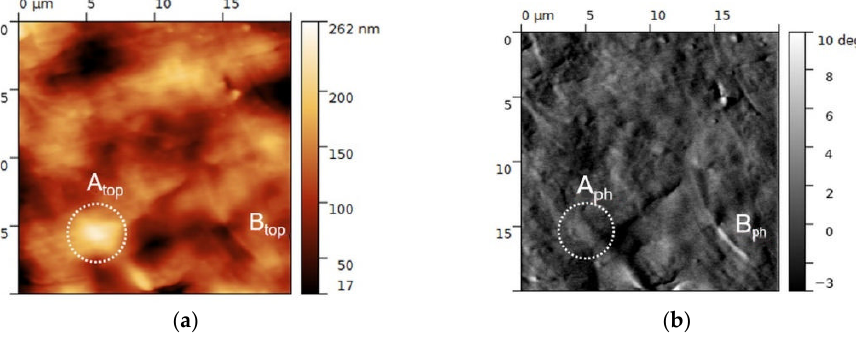
Figure 3. Representative 20 × 20 µm 2 topographic ( a ) and magnetic phase ( b ) images of PCL-HAp- 1%SPION. The correspondence between features A and B in terms of topographic (top) and magnetic phase (ph) signals is highlighted. A: ~4 µm large, no contrast in the magnetic phase, likely single HAp particle; B: little topographic contrast but remarkable magnetic contrast, likely the outcropping contour of a magnetic